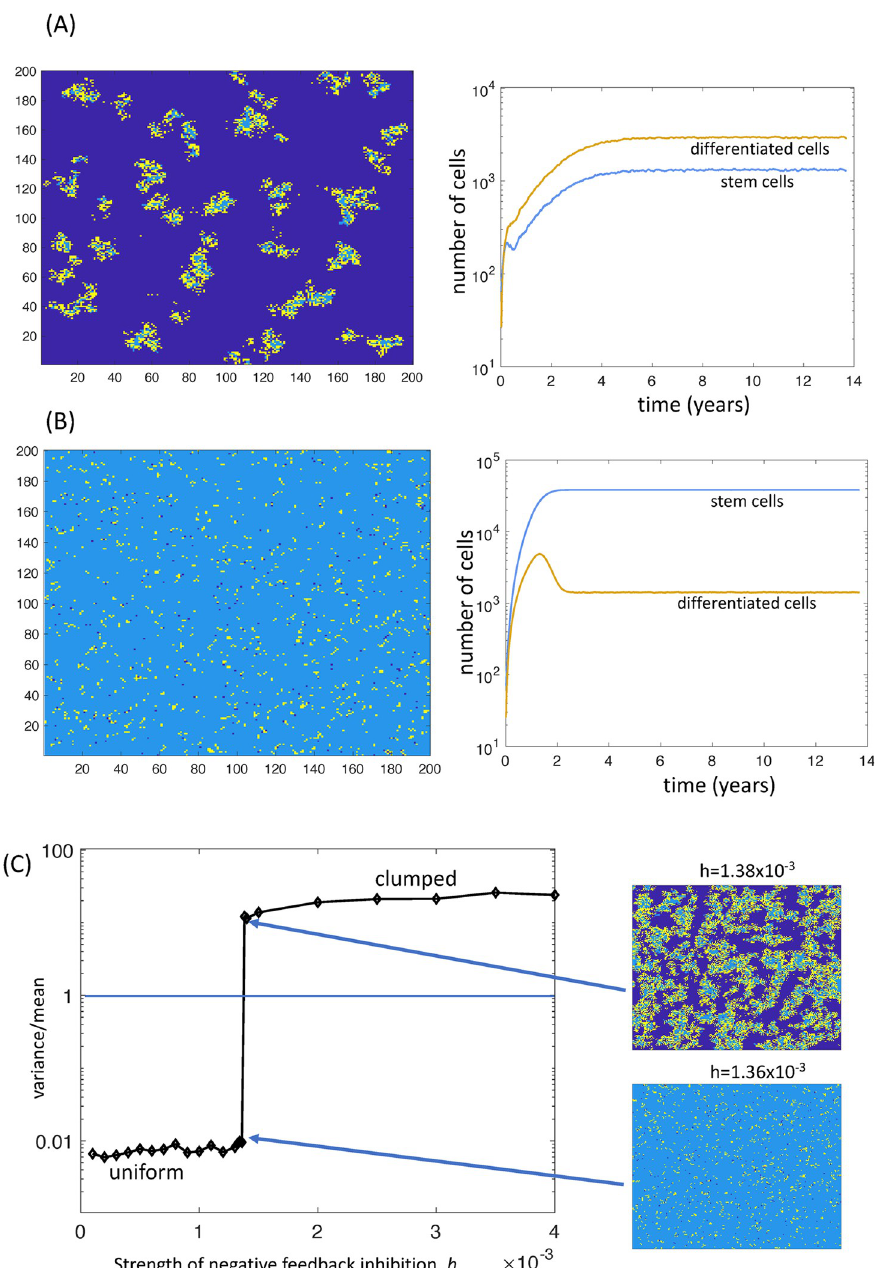
Fig 2. Spatial patterns observed in the agent-based model with negative feedback. Dark blue is empty space, light blue represents stem cells, and yellow represents differentiated cells. (A) With a stronger degree of negative feedback on the stem cell self-renewal rate, clumped spatial patterns are observed. Islands of stem and differentiated cells form, separated by empty space. Stem cells are in the minority. (B) For weaker negative feedback, these spatial patterns break down, and a uniform distribution of cells across space is observed. Also, stem cells become the dominant population. For A and B: The spatial picture is a snapshot in time at equilibrium, and the time series represents the average over 46 simulations; standard errors are too small to see. (C) The degree of clustering of cells across space can be quantified by dividing the space up into relatively small squares (10x10), and recording the number of cells per square. If the ratio of I disp = variance / mean is greater than 1, the spatial pattern is clumped. If the ratio I disp is less than one, the distribution is uniform. The graph shows the value of I disp at the end of the simulation (at equilibrium). As the rate of negative feedback inhibition is increased from low to high, we observe a relatively sharp transition in the ratio I disp , i.e. from a uniform to a clumped distribution of cells across the space. Baseline parameter values were chosen as follows. P div = 4.17x10 -2 , p (0) self = 0.7, P Sdeath = 8.3x10 -5 , P Ddeath = .17x10 -3 , p mig = 0., h = 4x10 -3 , c = 8.33, b = 8.3x10 -3 , g = 0.83;